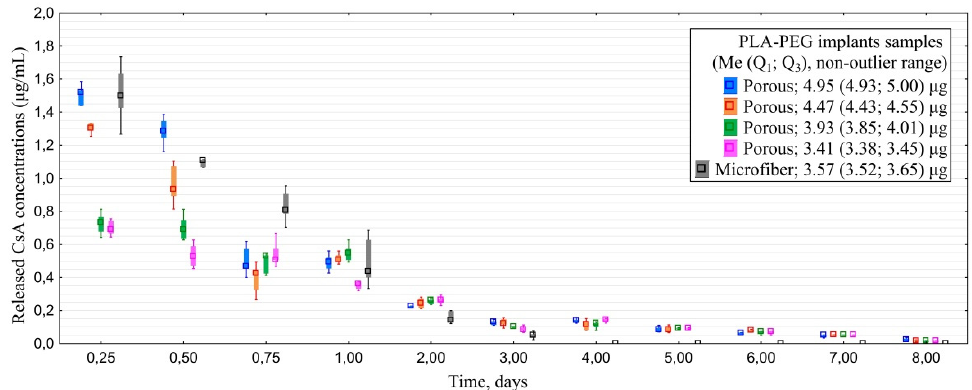
Figure 4. Dynamics of CsA release from PLA-PEG implants samples depending on their structure